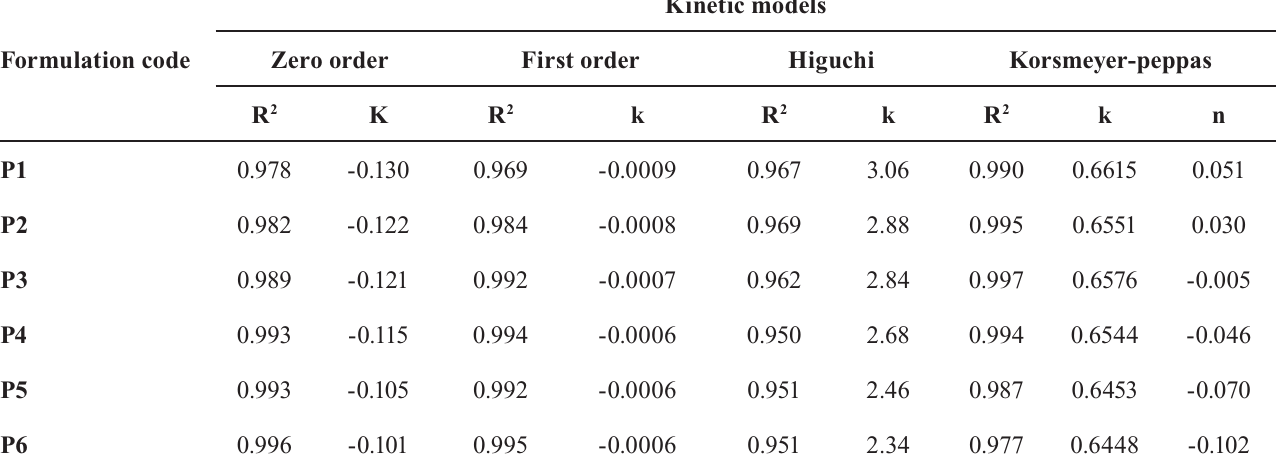
TABLE VI - Kinetic models of formulations P1 to P6